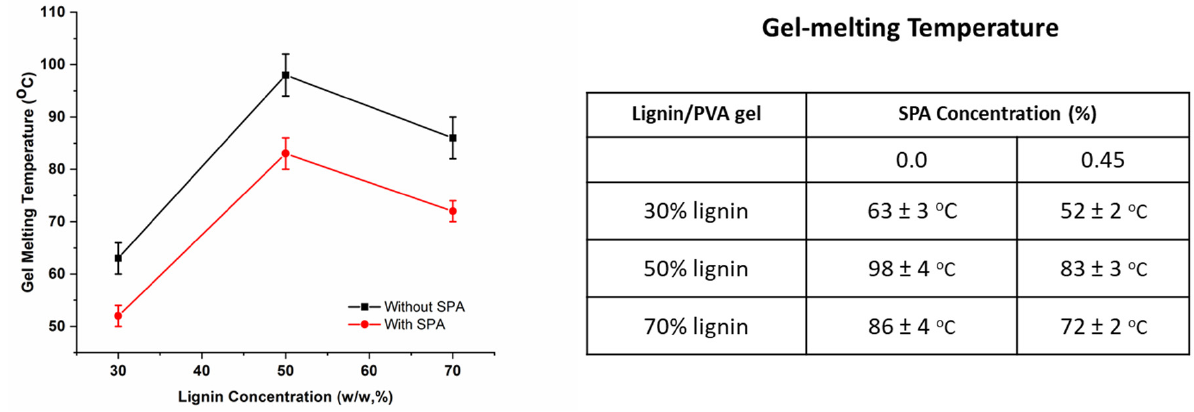
Figure 4. Gel-melting point of lignin/PVA with (red circles) and without (black squares) aqueous SPA.